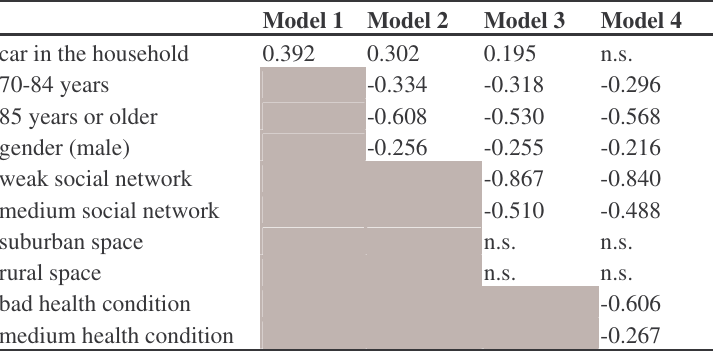
Table 2. Influences on leisure activity frequency of elderly people: results of four stepwise logistic regression